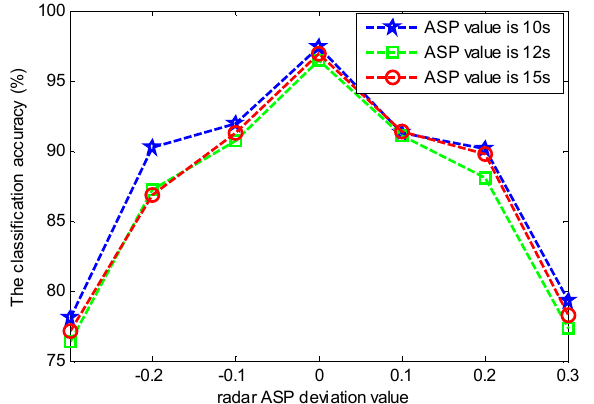
Figure 11. The classification accuracy of the proposed model under different radar ASP deviation.